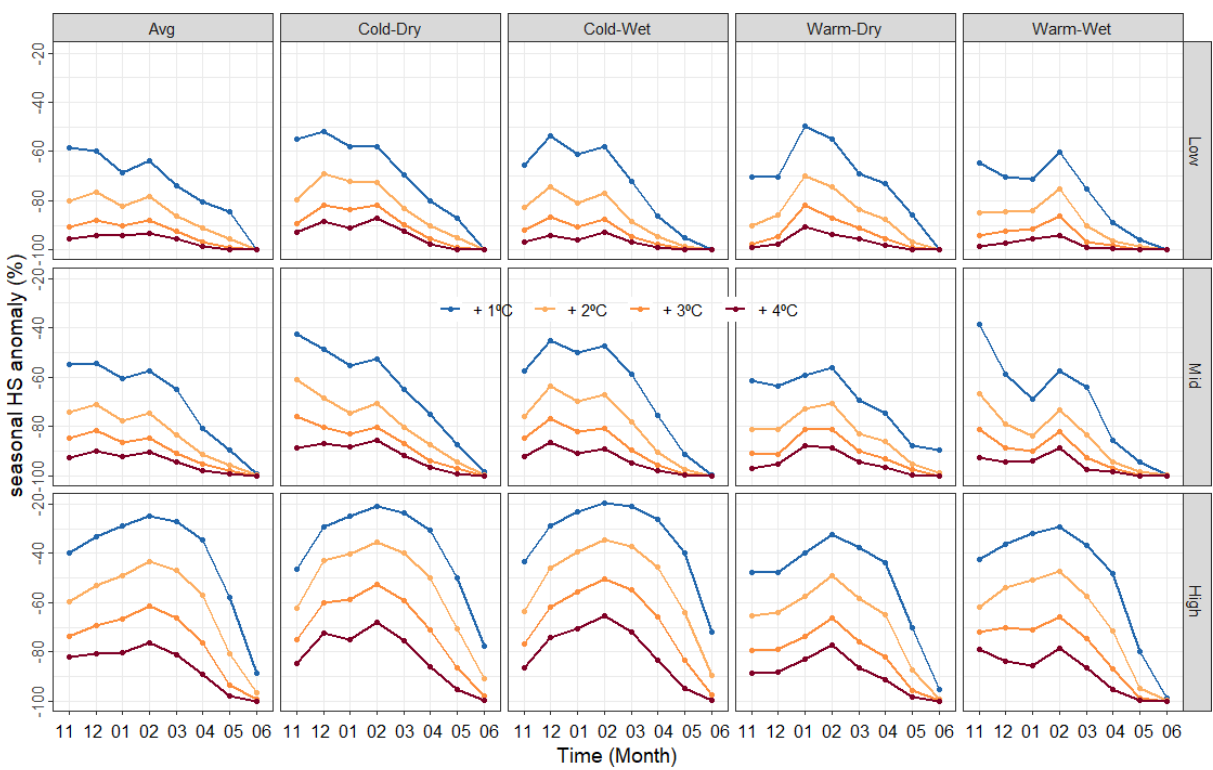
Figure 4. Anomalies of seasonal HS for low, mid, and high elevation (rows); compound season type (columns); and different temperature increases